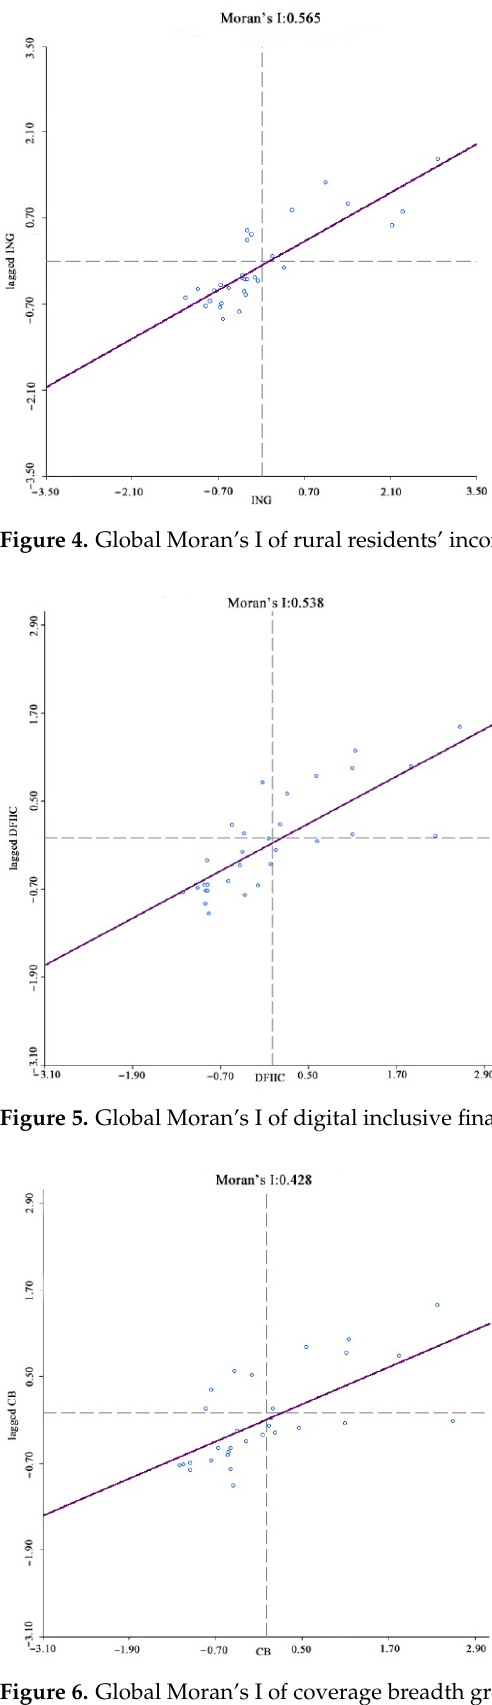
Figure 7. Global Moran’s I of usage depth growth. Figure 8. Global Moran’s I of digitization level growth.